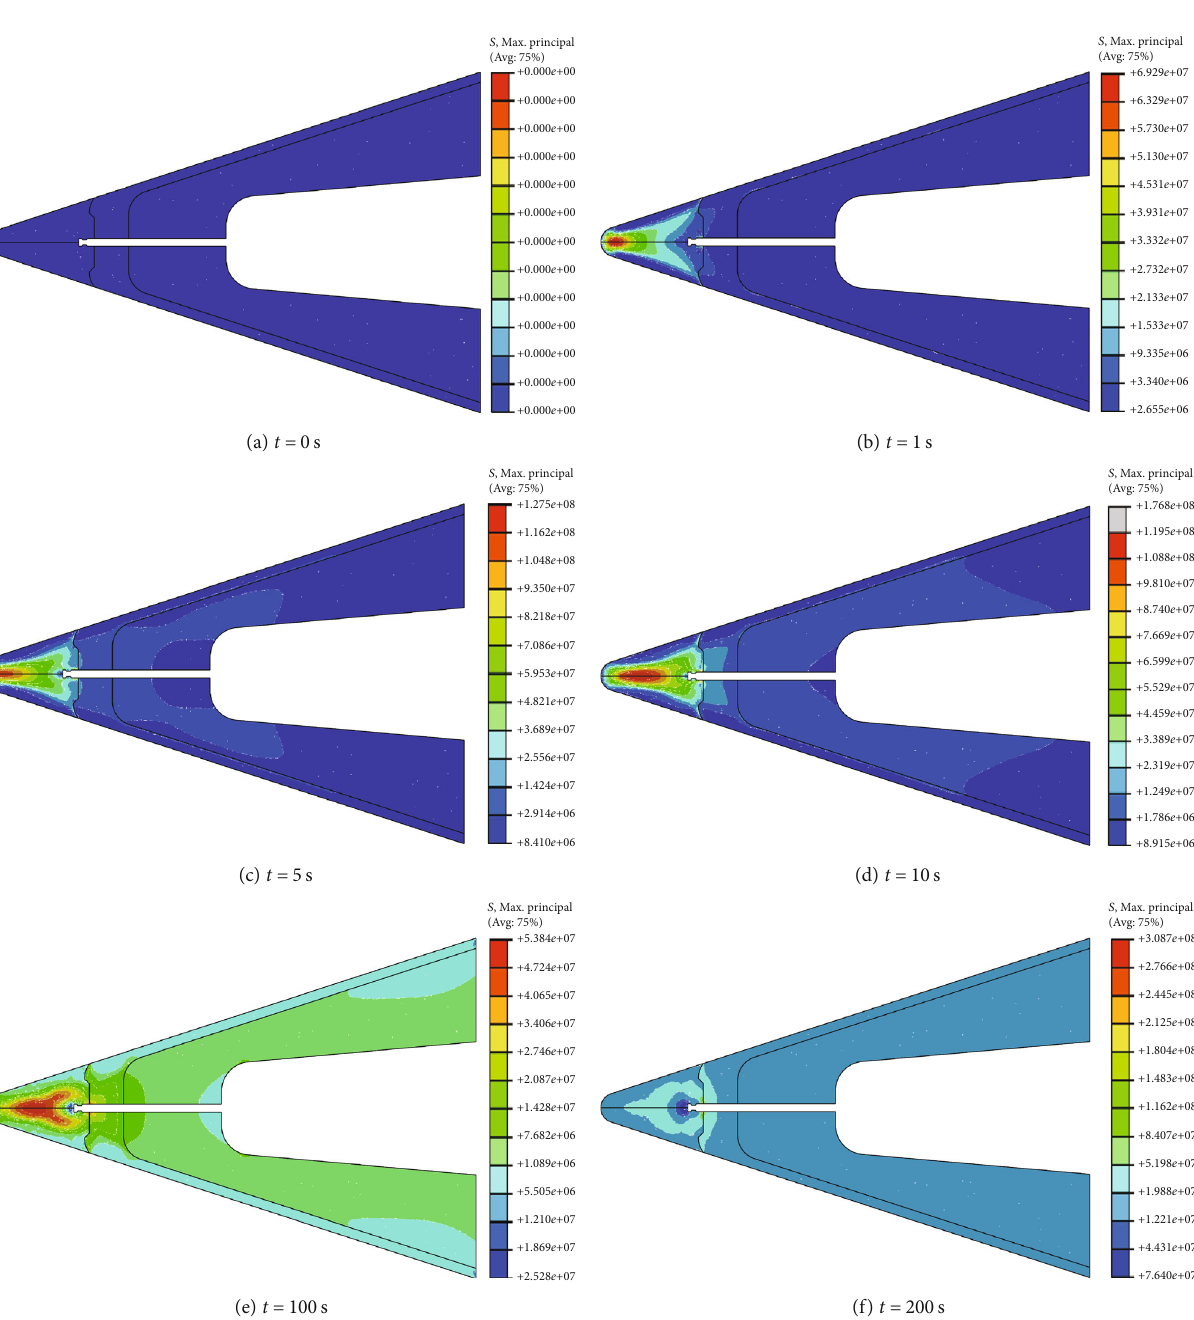
Figure 17: Evolution of maximum principal stress distribution of the nose